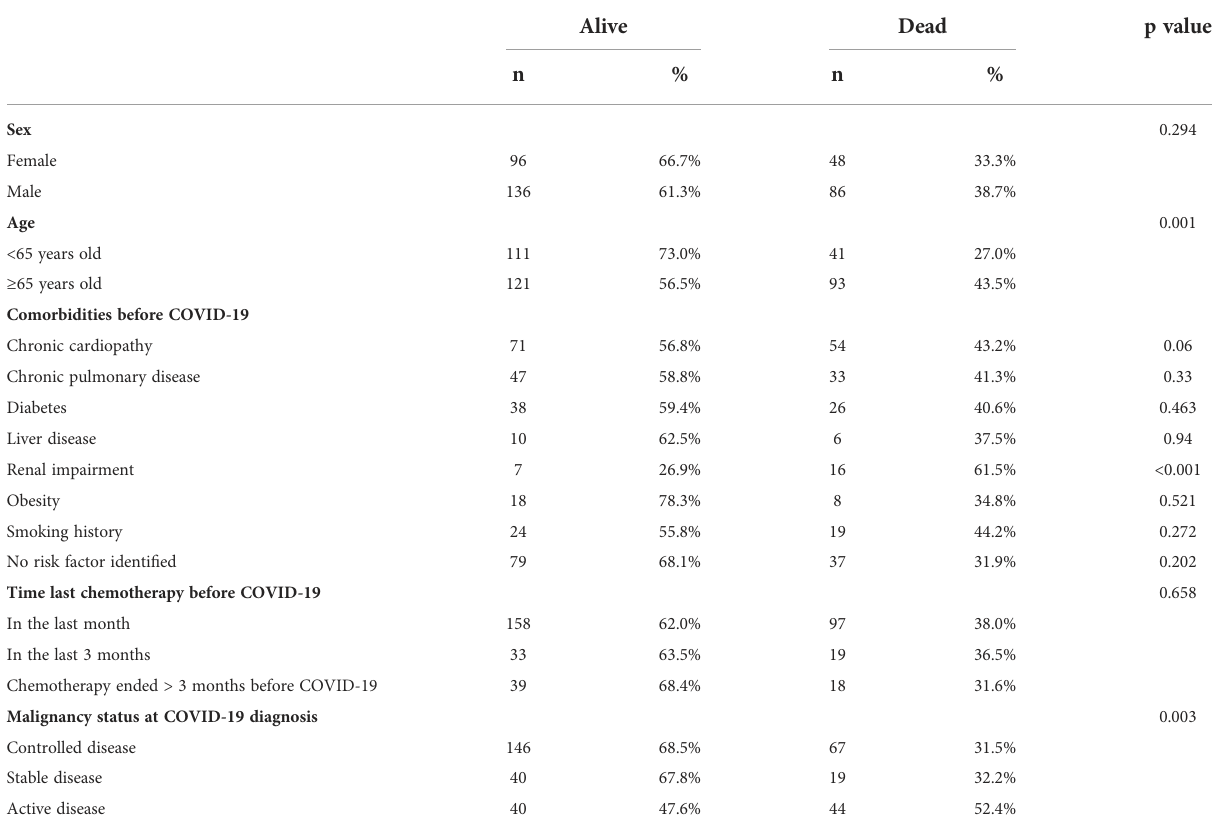
TABLE 3 Patient ’ s disposition based on mortality.